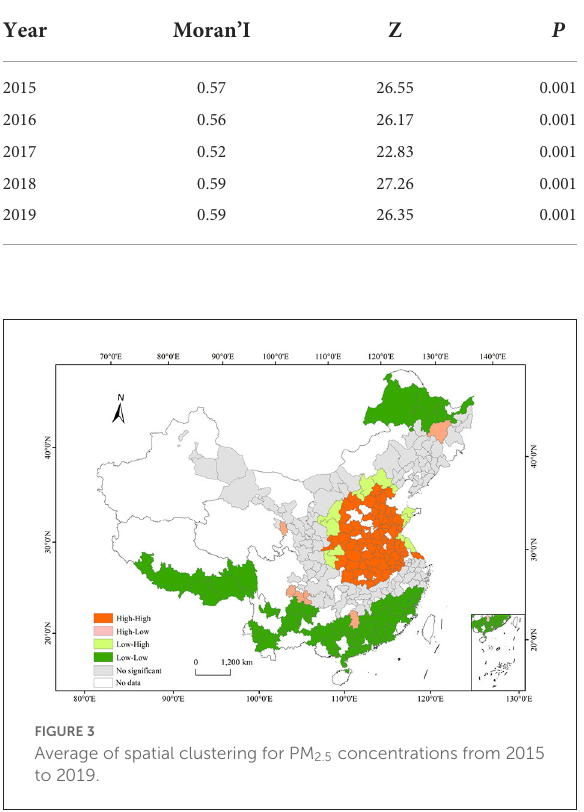
and 2019, which indicated that an overall trend toward